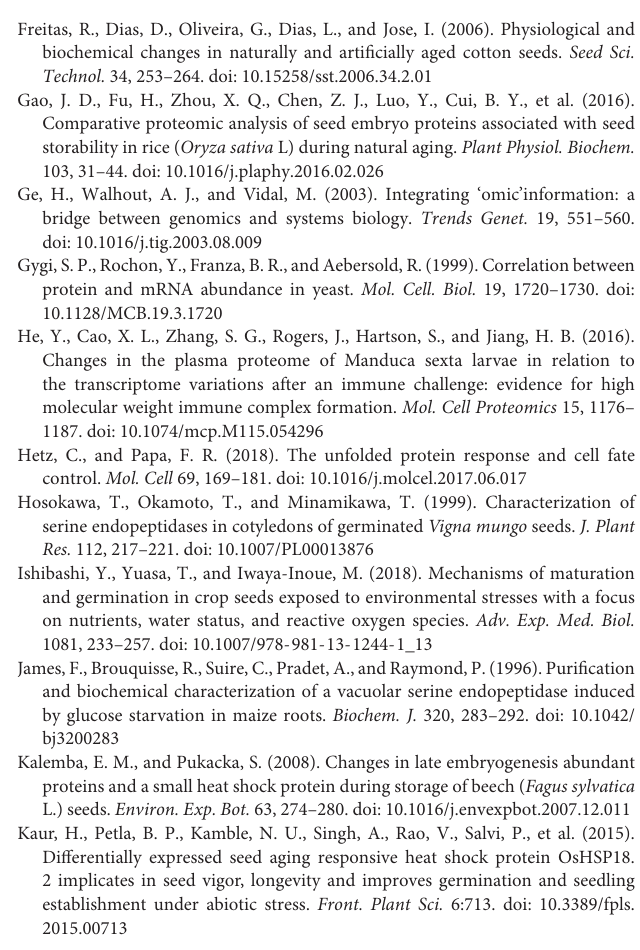
Supplementary Table 4 | List of primers for RT-qPCR of miR164c and some genes showing differential expression between WT, ST, and OT seeds. Supplementary Table 5 | Data on the interaction between nodes (i.e., genes/proteins) in the integrated network of the MERLIN algorithm and String